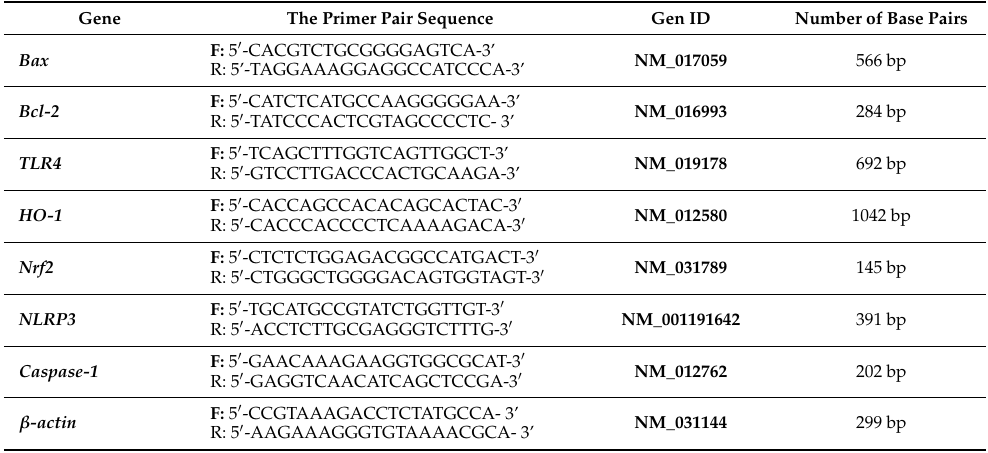
Table 3. List of primer sequence sets used for RT-qPCR analysis in rat